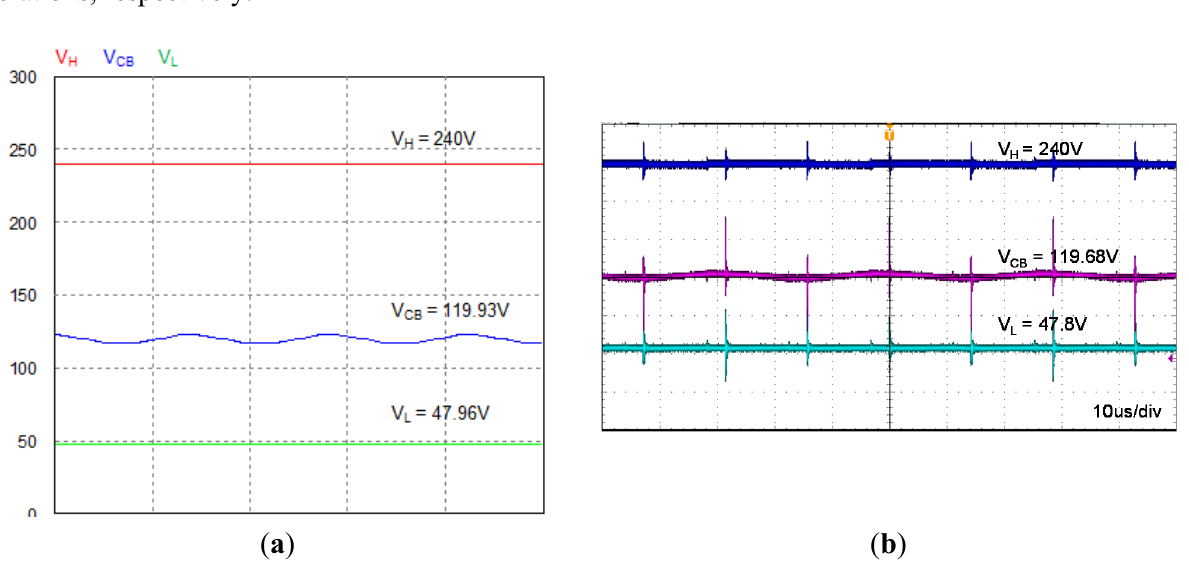
Figure 16. Waveforms of input voltage, output voltage and charge-pump capacitor voltage in the charge mode at full load ( a ) by simulation; and ( b ) by measurement.